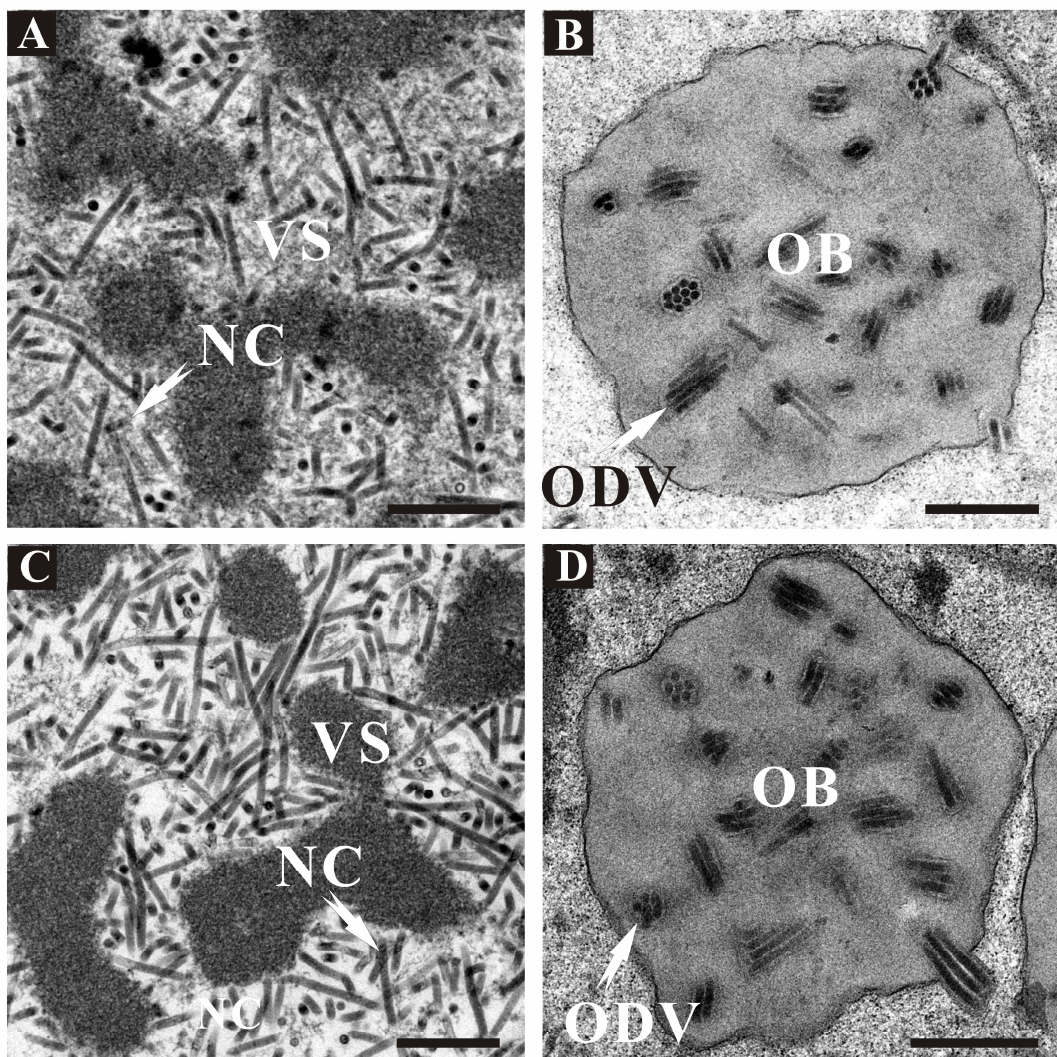
Figure 5. Electron micrographs of Sf9 cells transfected with vAc111:HA ( A , B ) or vAc111KO ( C , D ) at 72 h p.t. ( A , C ) Partial view of the virogenic stroma (VS) at a higher magnification. Normal nucleocapsids (NC) are found in the VS; ( B , D ) Image of OB showing embedded multiple-nucleocapsid ODVs. Scale bar, 500 nm.